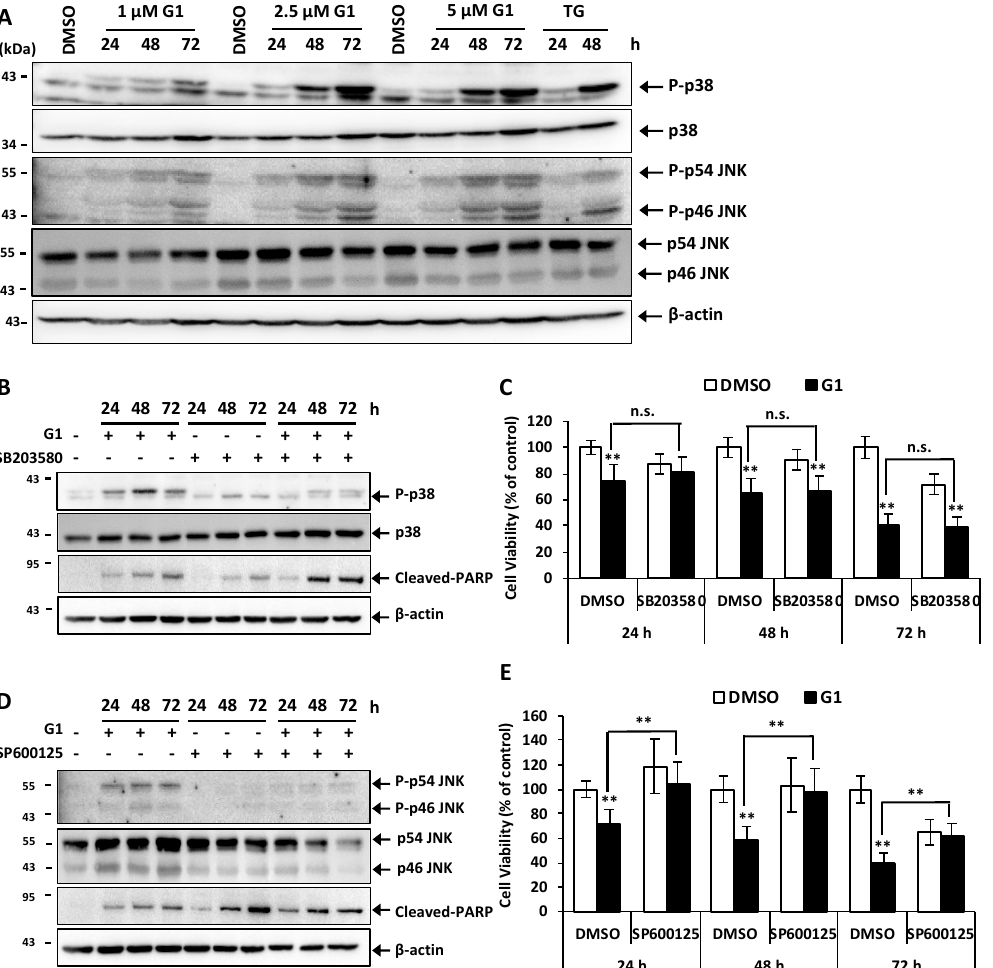
Figure 4. G1 activated p38 and JNK and a selective inhibitor of phosphorylation of JNK inhibited G1-induced cell death in MCF-7 cells. ( A ) MCF-7 cells were treated with 1, 2.5 and 5 µM G1 for 24, 48 and 72 h, or with 1 µM TG for 24 and 48 h. Total protein lysates were subjected to Western blotting using appropriate antibodies as indicated. Cells were pretreated with 1 µM SB203580, a selective inhibitor of p38 MAP kinase or 10 µM SP600125, a selective inhibitor of JNK kinase and then exposed to 1 µM G1 for 24, 48 and 72 h. ( B , D ) Total protein lysates were subjected to Western blotting using appropriate antibodies as indicated. ( C , E ) Cell viability was measured by the LDH activity assay. ** p < 0.01 when compared with cells treated with vehicle or among G1-treated groups. + is indicated for the presence of a treatment meanwhile – is indicated for the absence of a treatment.